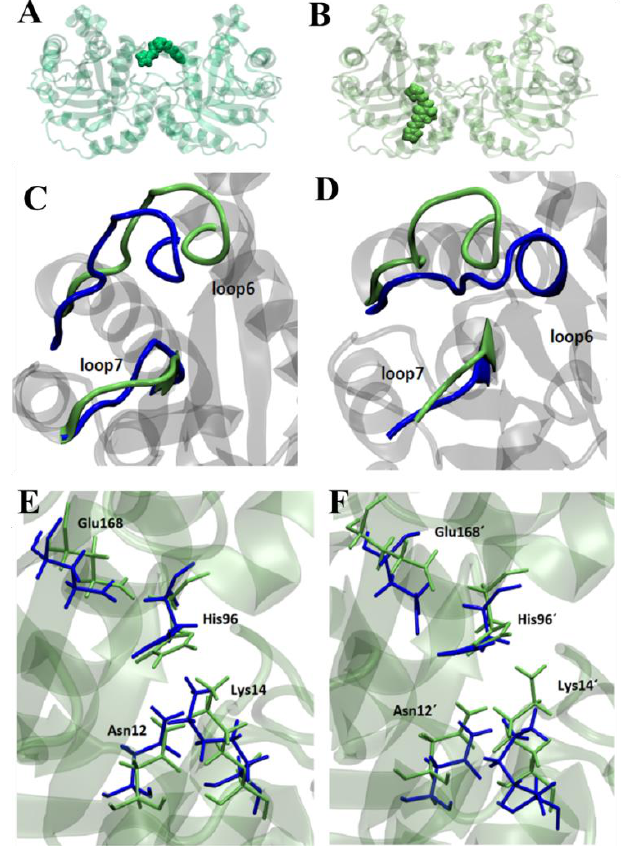
Figure 2. Site of the interaction of compound 1019 in TcTIM ( A ) after molecular docking and ( B ) after molecular dynamic studies, observing changes in the interactions from loop 6 to loop 7. Positioning of loops 6 and 7 in the presence of compound 1019 (green) and the absence of ligand (blue) ( C ) in monomer A and ( D ) in monomer B. Positioning of active site residues in the presence (green) and absence of compound 1019 (blue) ( E ) in monomer A and ( F ) in monomer B.